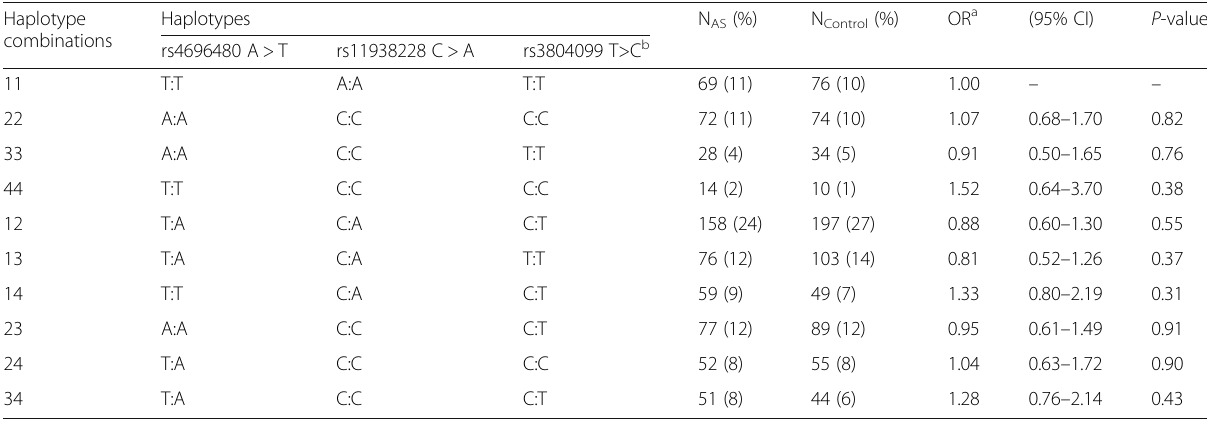
Table 3 Association of the TLR2 haplotype combinations and risk of ankylosing spondylitis (AS). The haplotype combinations in TLR2 described 93% of the genotypes observed Haplotype combinations